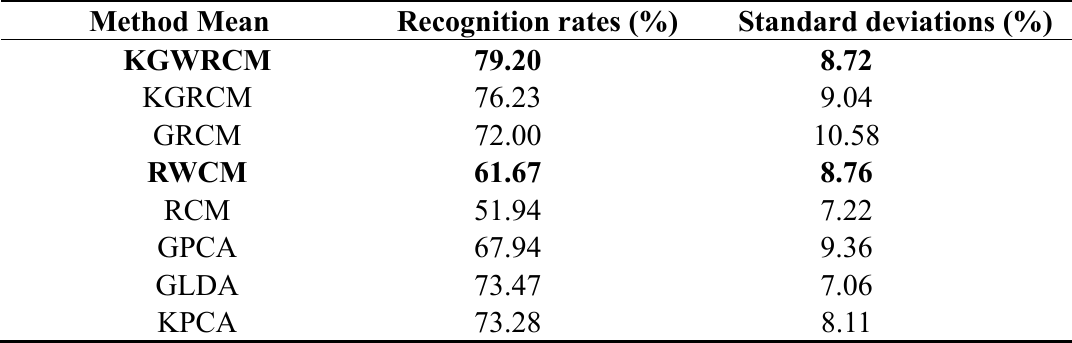
Table 2. The performance of different approaches on the Yale face database.